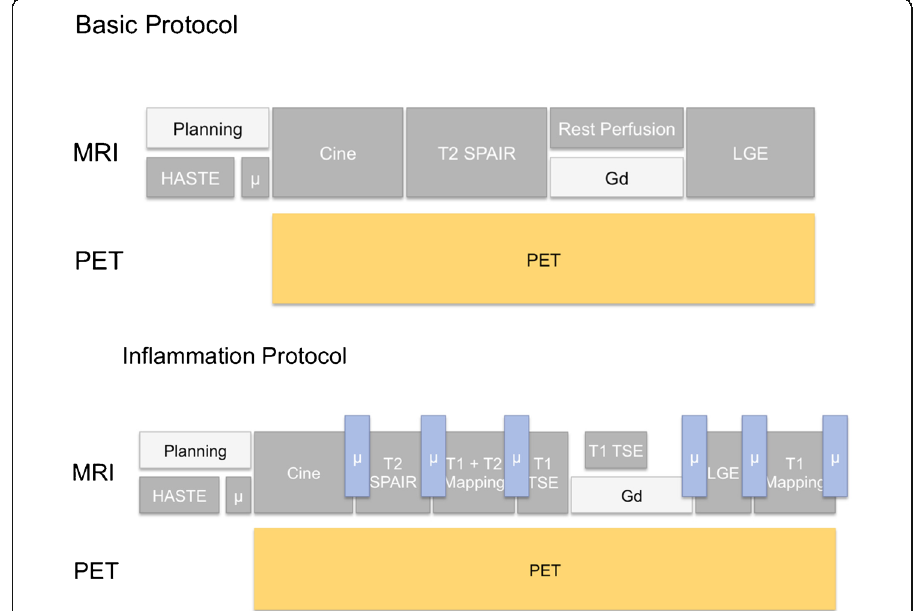
Fig. 7 Sample basic and inflammation focused imaging protocol for cardiac